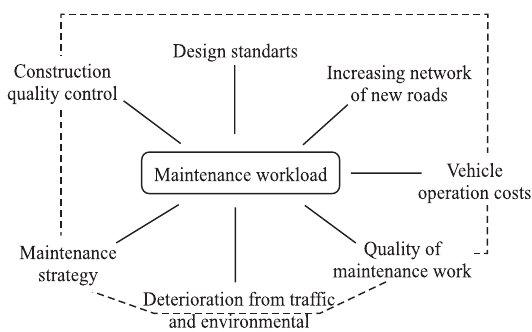
Fig. 2. Development of maintenance workload (Freer-Hewish